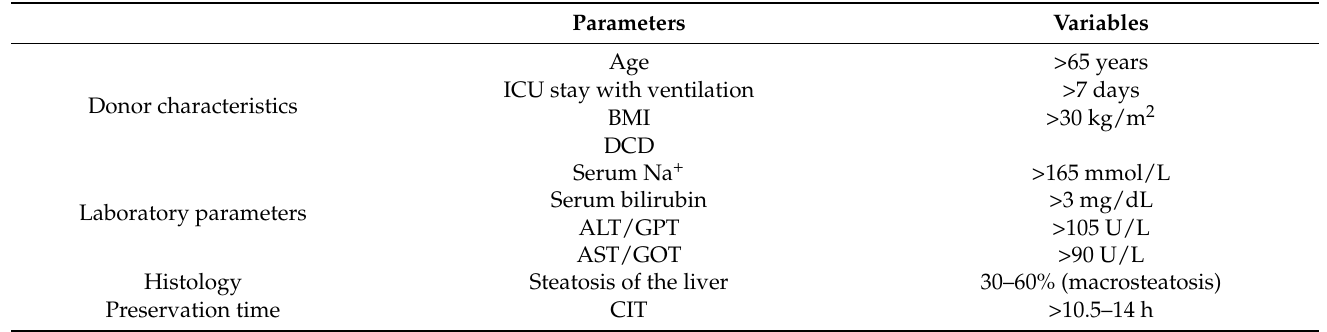
Table 1. Predictors of outcome in extended criteria donor (ECD) livers.